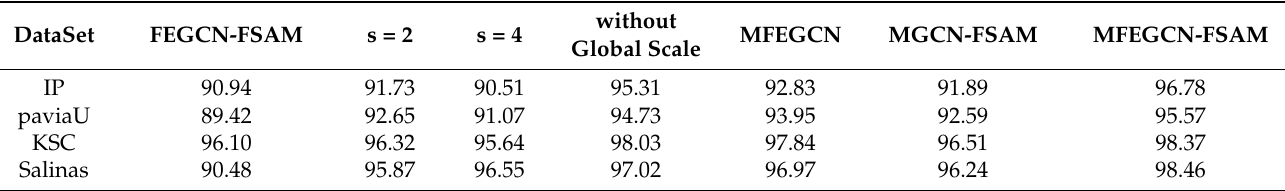
Table 9. OA results of ablation study on the four datasets (%).